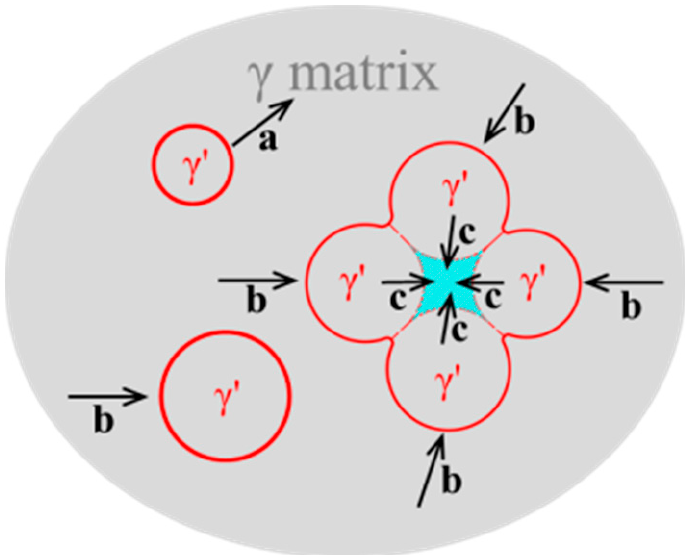
Figure 6. Schematic illustration of the flow of the atoms constituting γ′ precipitates during continuous cooling.